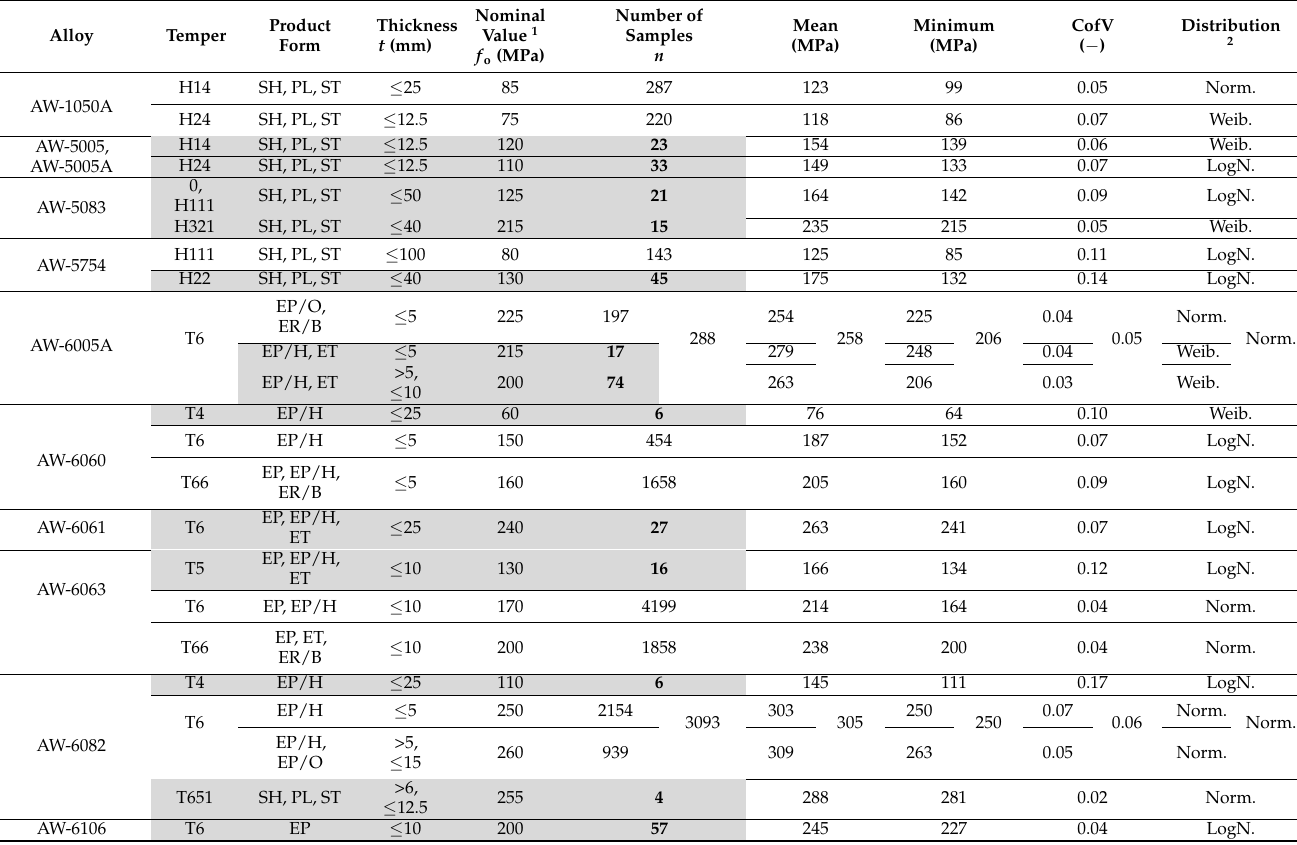
Table 2. Statistical analysis of 0.2% proof